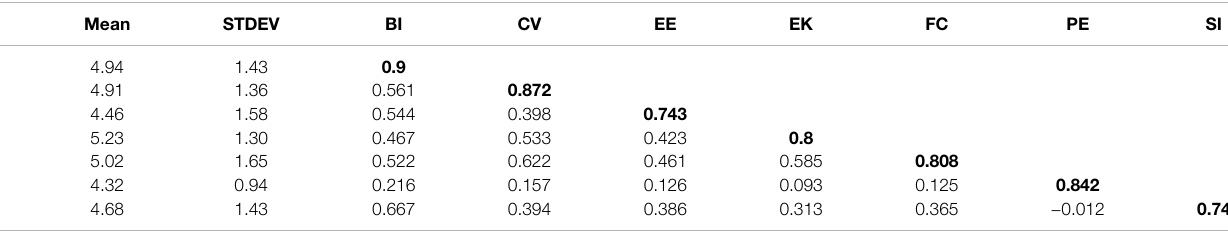
TABLE 3 | Discriminant validity Fornell-Larcker criteria.